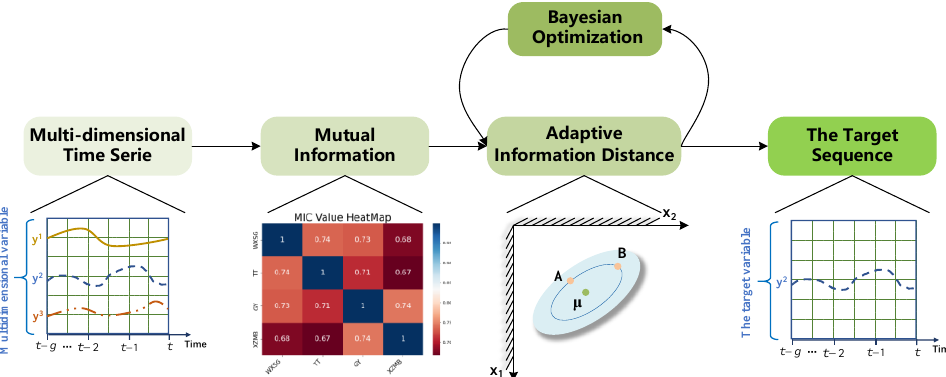
Figure 3. Information interpretability filtering. The dotted lines with different colors in the figure represent different variables.